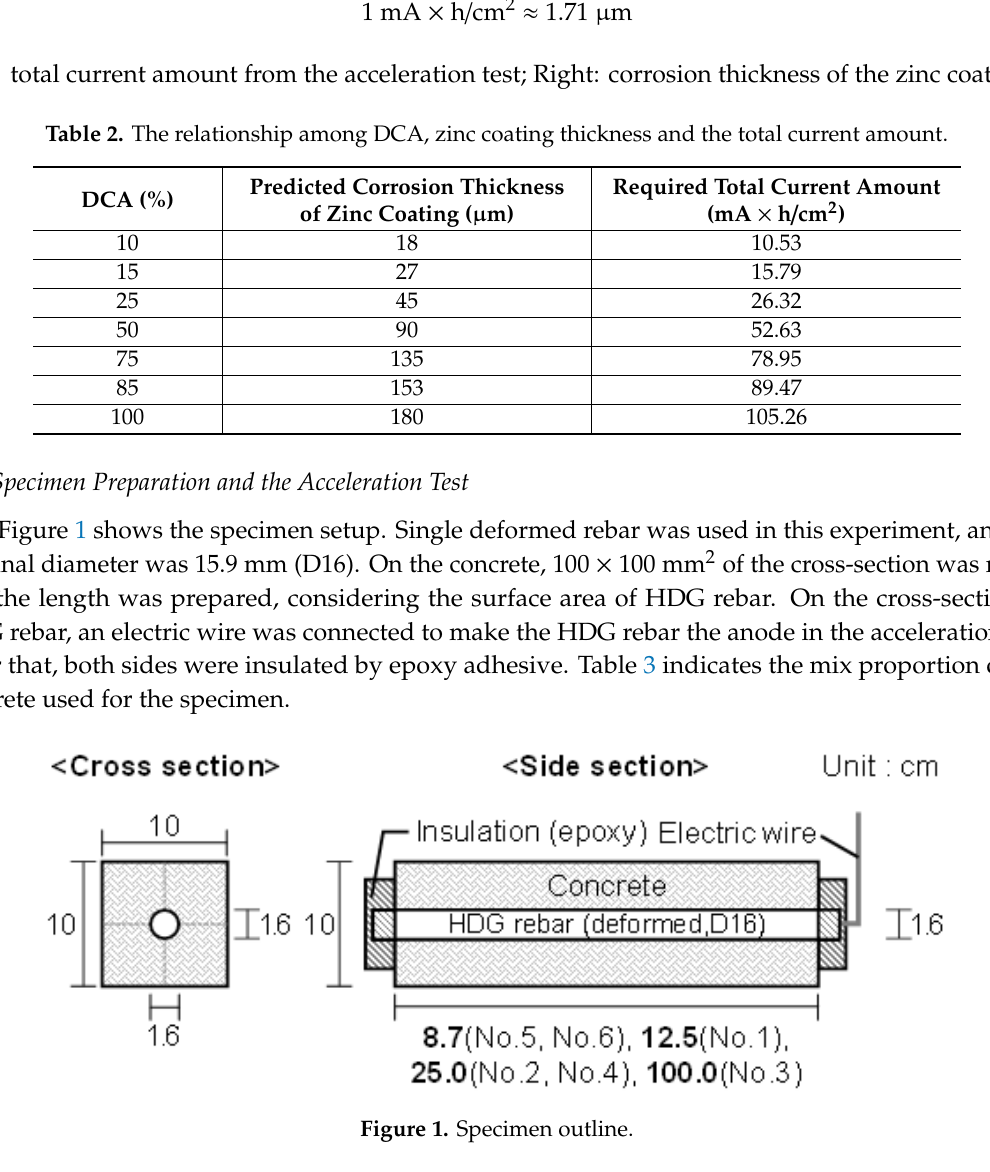
Table 2. The relationship among DCA, zinc coating thickness and the total current amount.